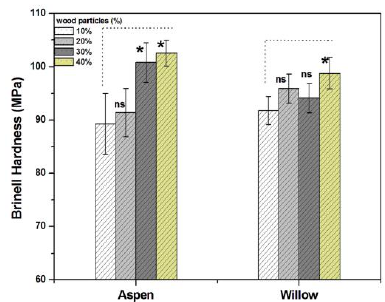
Figure 6. Brinell hardness of biocomposite with different weight percentages of wood particles. ( * significant difference at P < 0.05 and ns not significant)